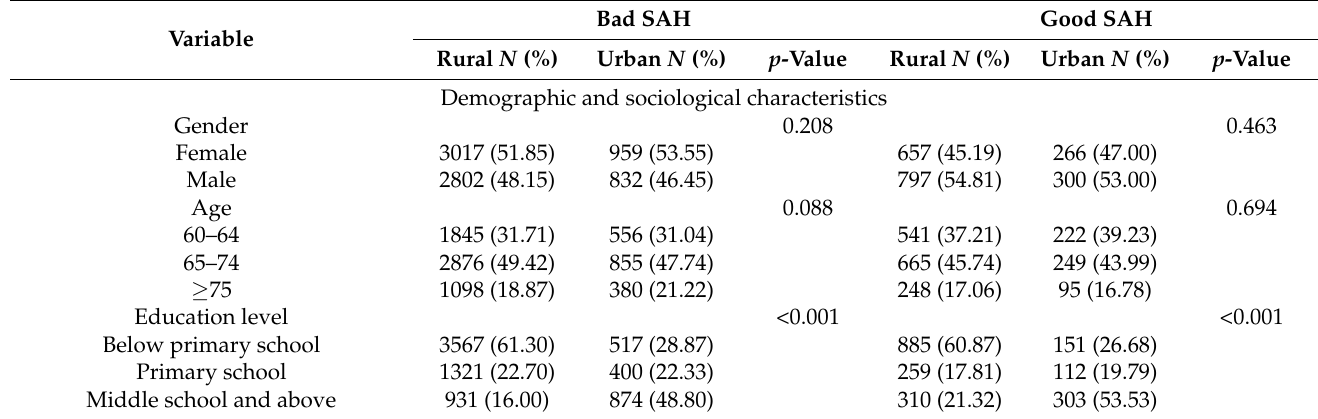
Table 3. Comparison of variable distribution in different SAH